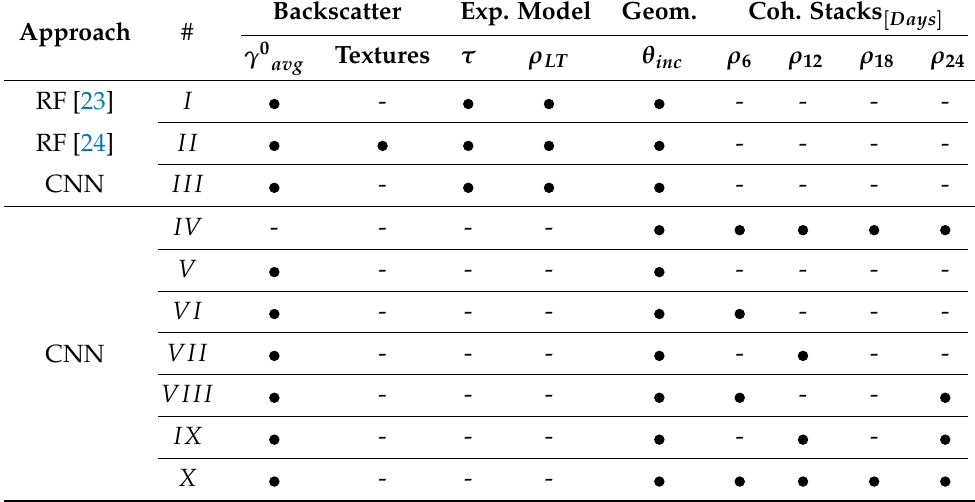
Table 3. Different land cover classification schemes considered in this paper. The baseline ap- proaches were based on Random Forest (RF) classifiers and the exponential modeling of the temporal decorrelation [23,24], as well as the crafting of texture features from the SAR backscatter [24]. We evaluated the potential of CNNs for replacing such heavy processing steps with stacks of interfero- metric coherences at different temporal baselines. Black dots identify the considered input feature maps for each